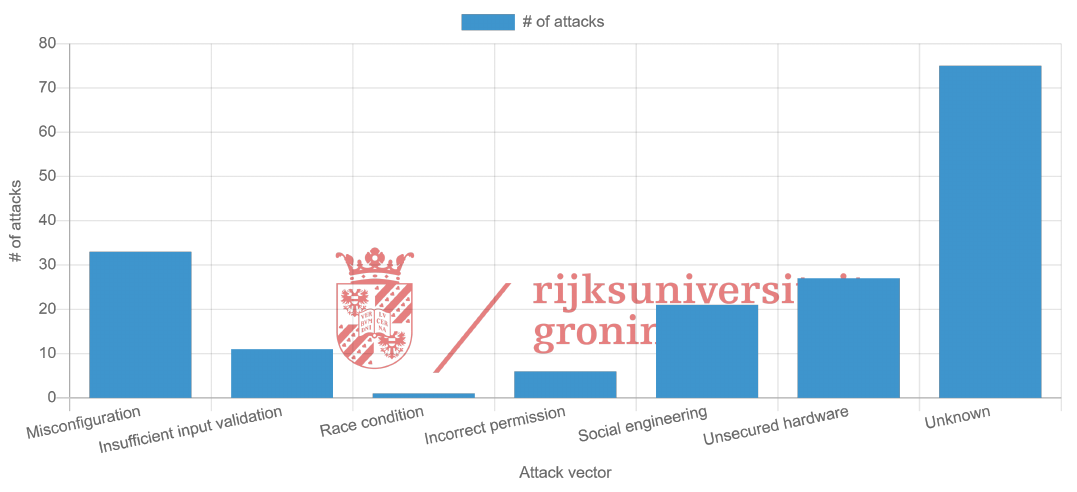
Figure 7. Number of attacks per attack